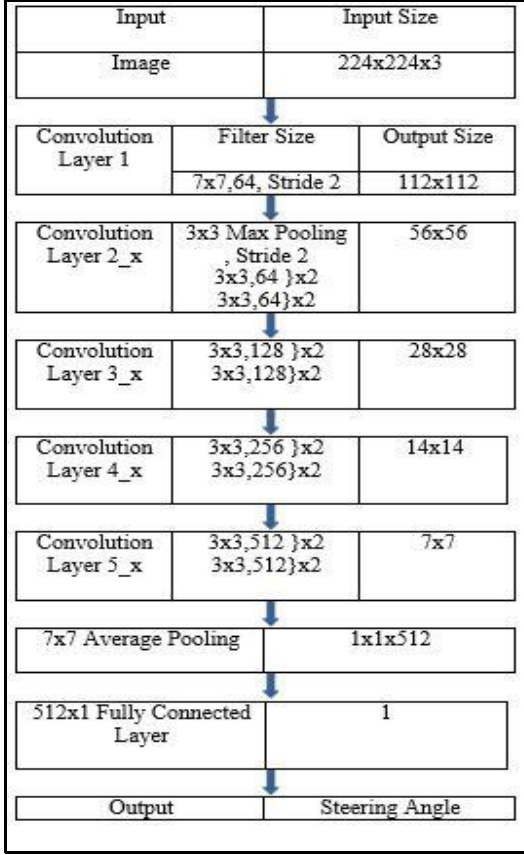
Fig. 2. ResNet18 architecture.